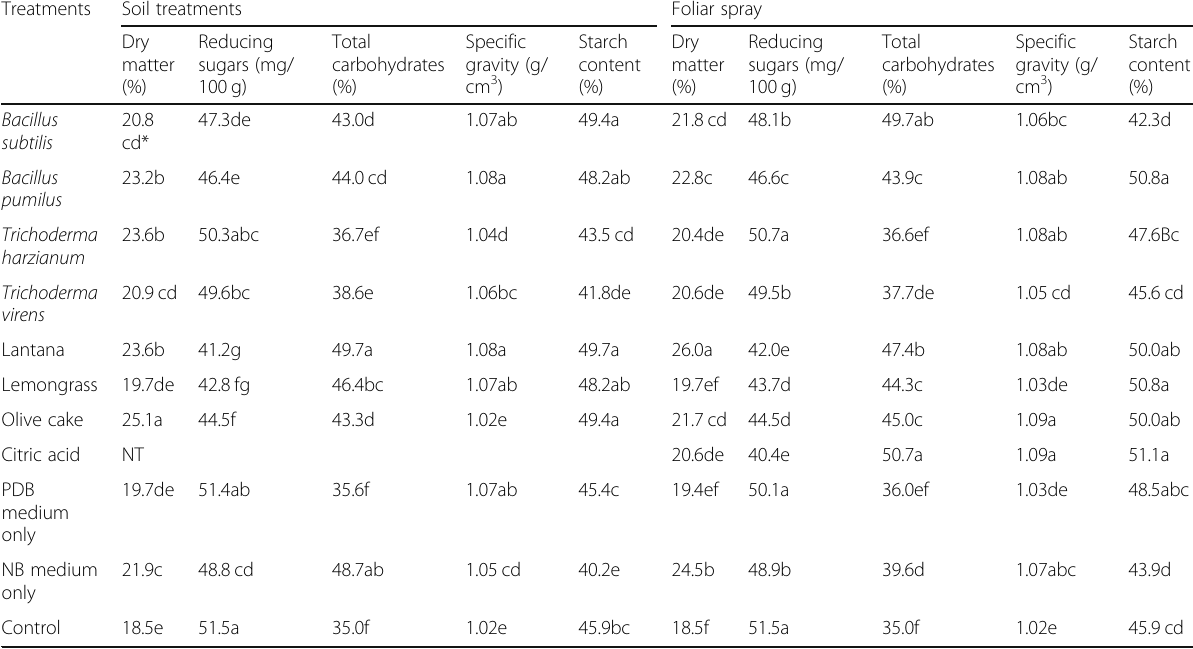
Table 6 Effect of bio-control agents, aqueous plant extracts, and citric acid as soil treatment and/or foliar spray on quality parameters of potato tubers under storage conditions